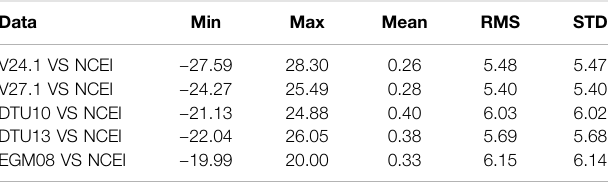
TABLE 4 | Validation results of marine gravity models with NCEI shipboard gravity data in South China Sea Basin. Data Min Max Mean RMS STD